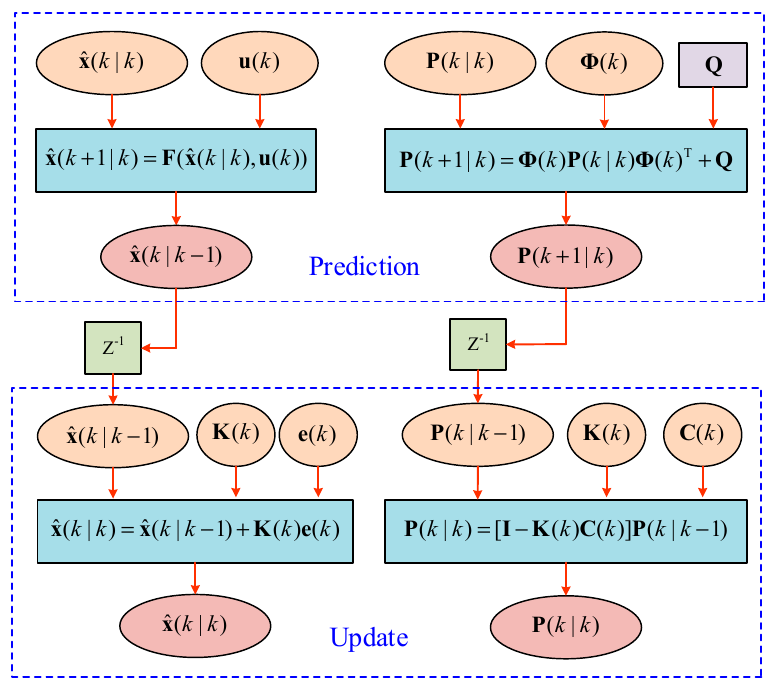
Figure 2. Prediction and update steps in the extended Kalman filter (EKF) algorithm.